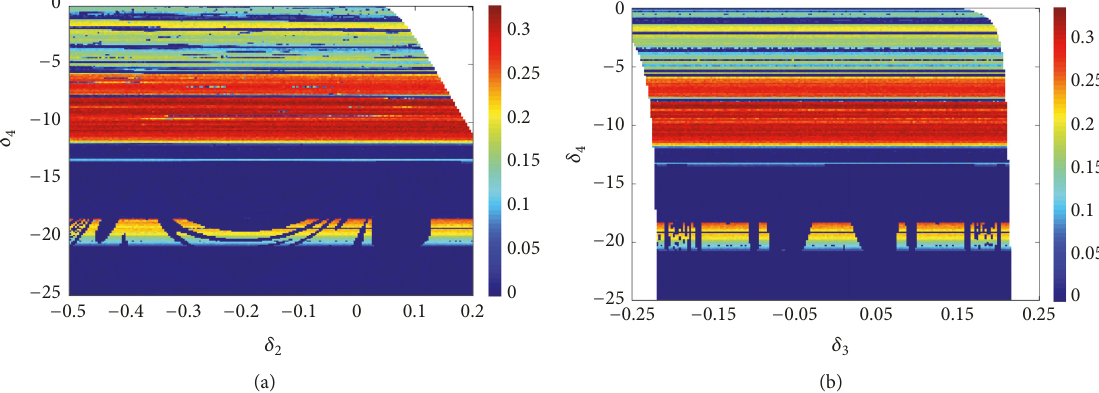
Figure 12: Two-parameter plots of 3D system (14) in initial-related system parameter spaces. (a) Two-parameter plot in the 𝛿 2 - 𝛿 4 plane with 𝛿 𝛿 1 = 0 and 3 = 0.2. (b) Two-parameter plot in the